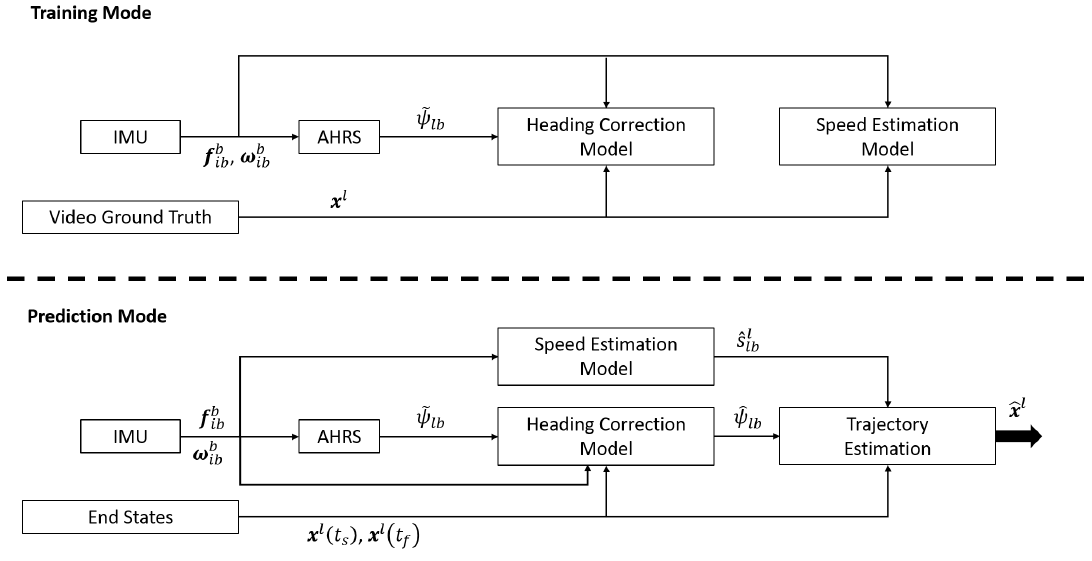
is the biobot’s lb